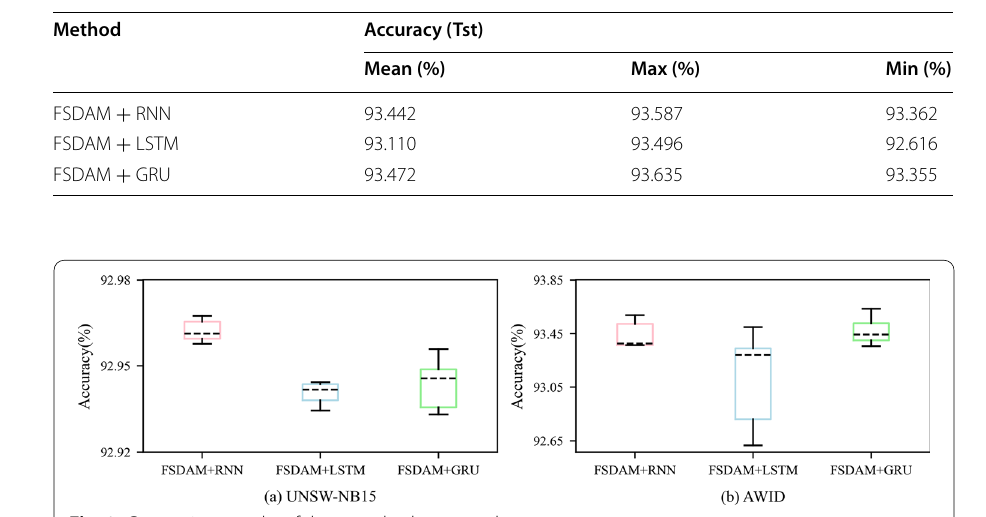
Table 12 Accuracy of different methods on AWID